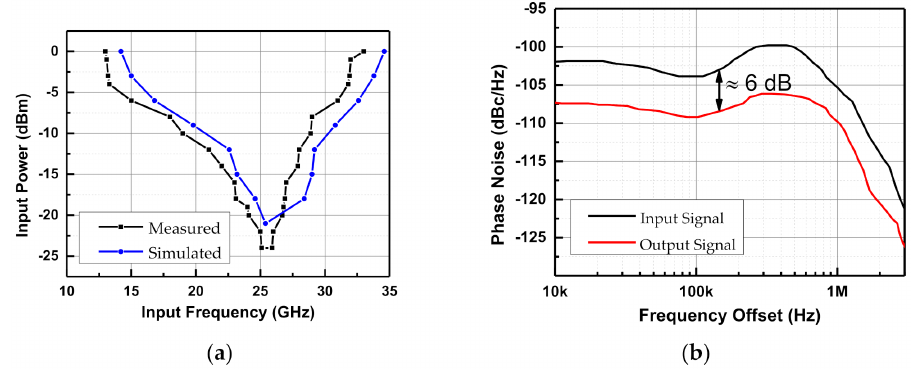
Figure 11. ( a ) Simulated and measured input sensitivity curve of the proposed ILFD. ( b ) Measured phase noise performance.